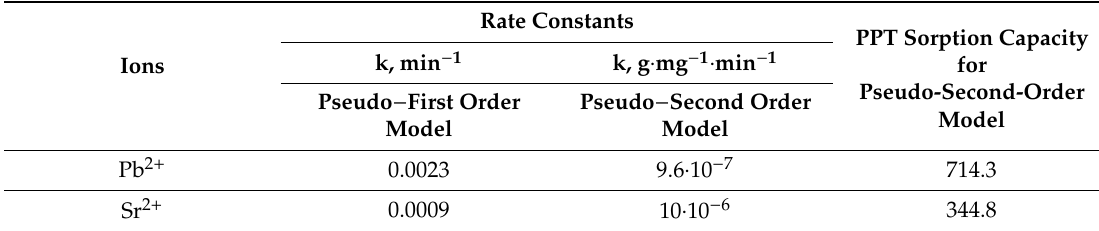
Table 2. Sorption kinetic parameters of Pb 2 + and Sr 2 + ions and PPT sorption capacity.